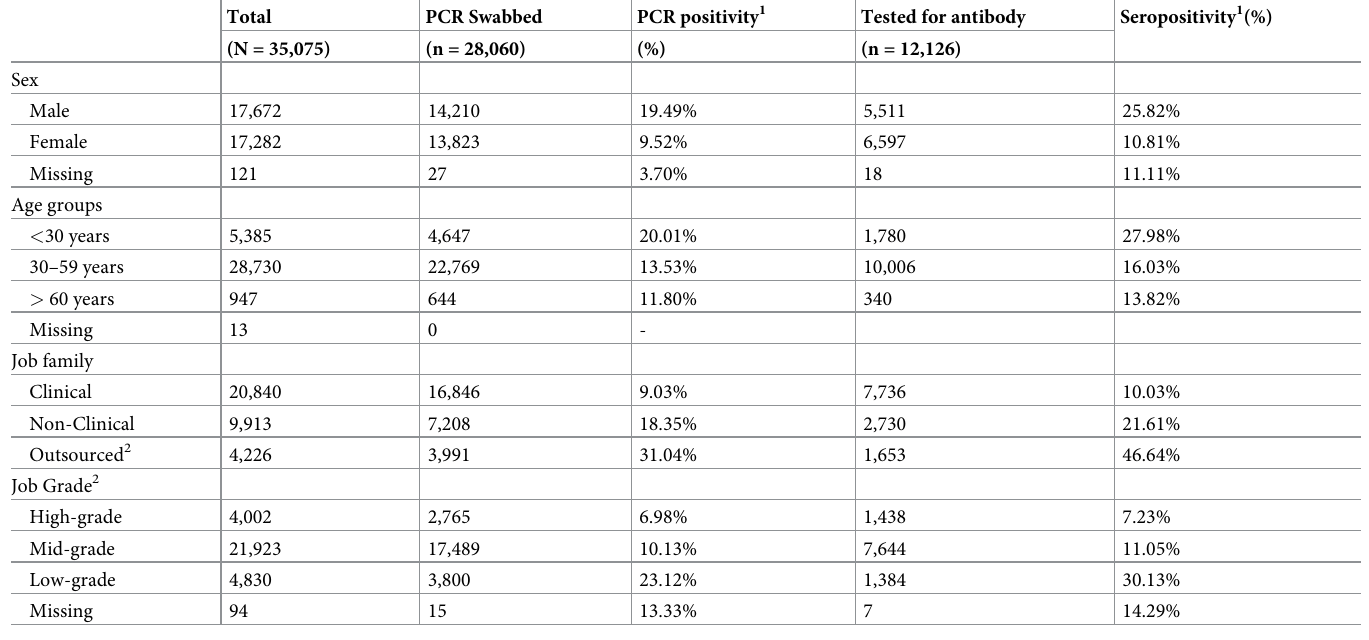
Table 1. PCR positivity and seropositivity